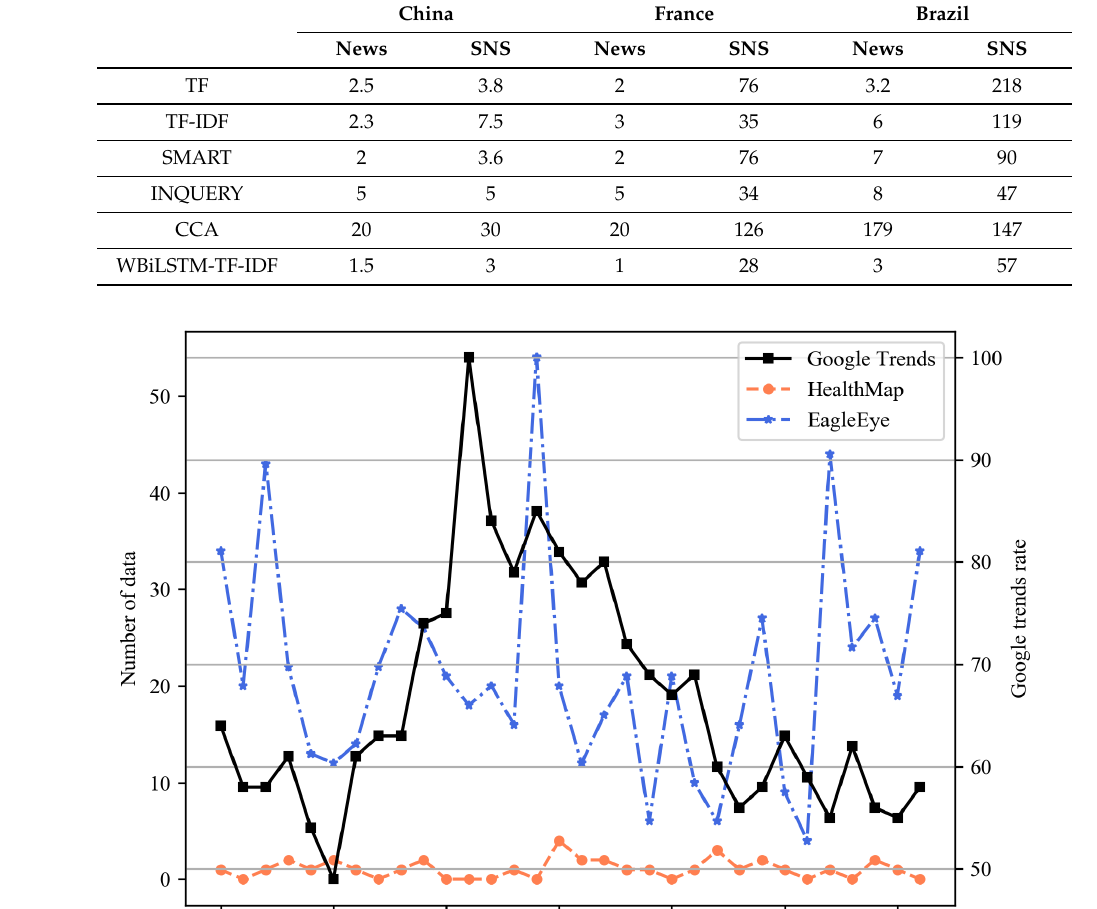
Table 4. Ranking of disease-related events.